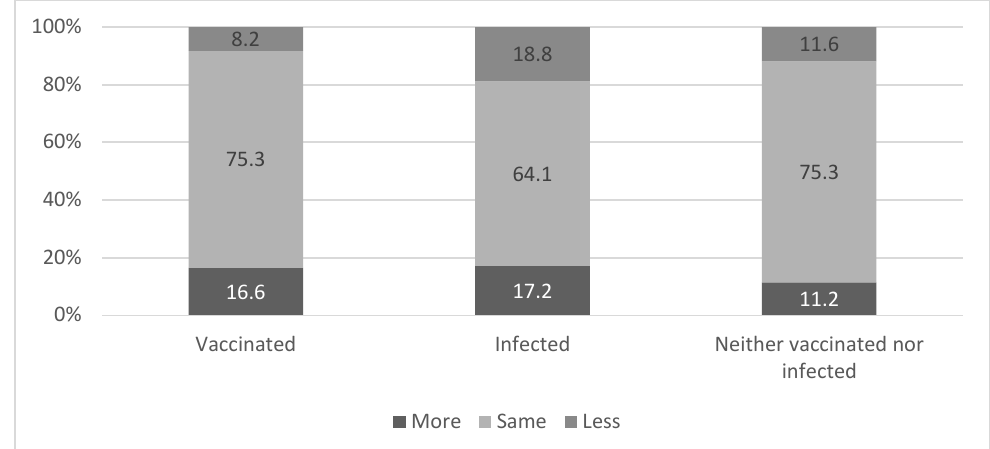
Figure 2. Level of change in mask wearing after the beginning of the vaccination campaign by vaccinated and infected variable. χ 2 = 13.02 p = 0.011.